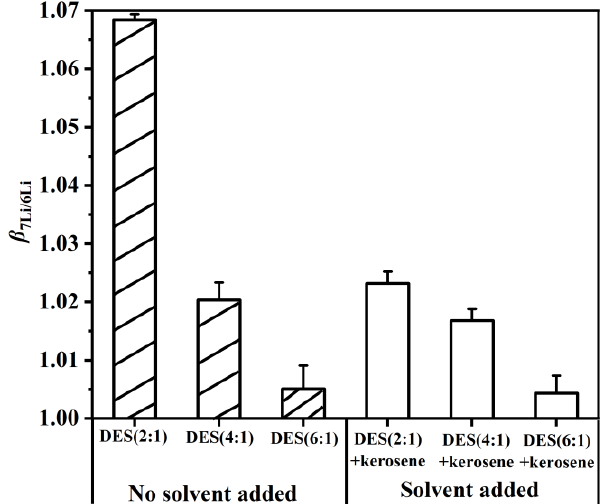
Figure 7. The molar ratio of the extractant was HTTA: TOPO = 2:1 (4:1 or 6:1). The solvent was added in equal volume to kerosene to form an extractant to separate 6 Li and 7 Li . The composition of the aqueous phase was 25 ppm LiCl and 0.1 M NH 4 Cl. Aqueous phase: organic phase = 4:1.